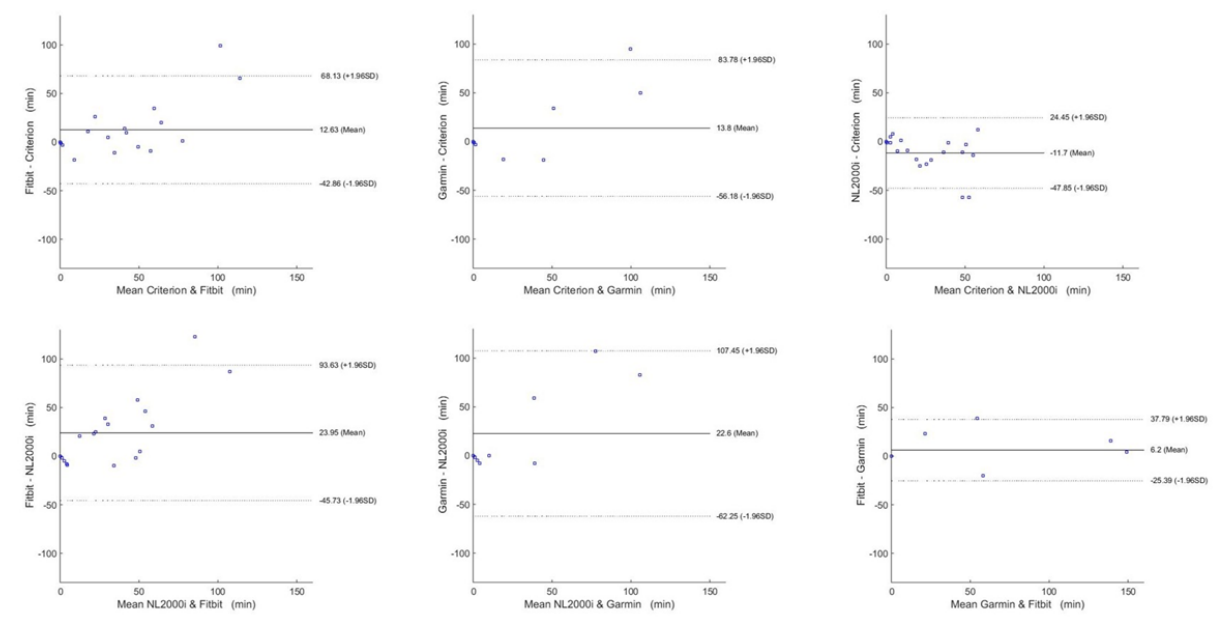
Figure 5. Bland-Altman plots for moderate-to-vigorous physical activity.